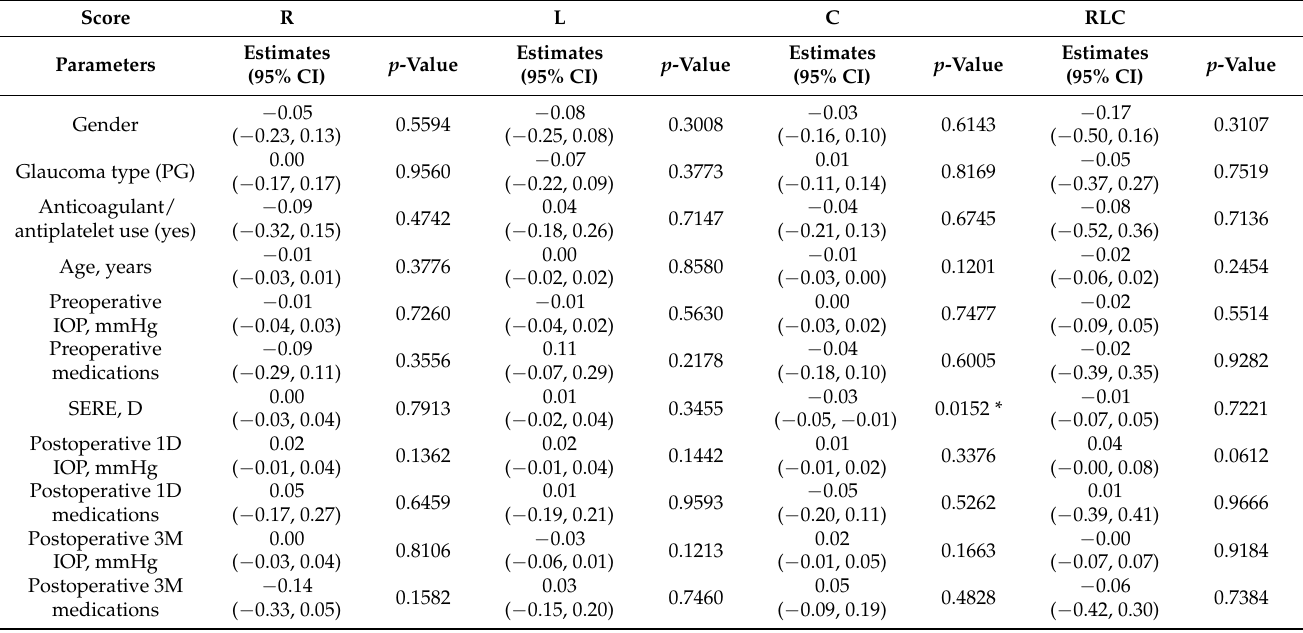
Table 7. Possible associations between postoperative day-1 RLC scores and various parameters analyzed by a multiple regression model in the TMH-CE group.